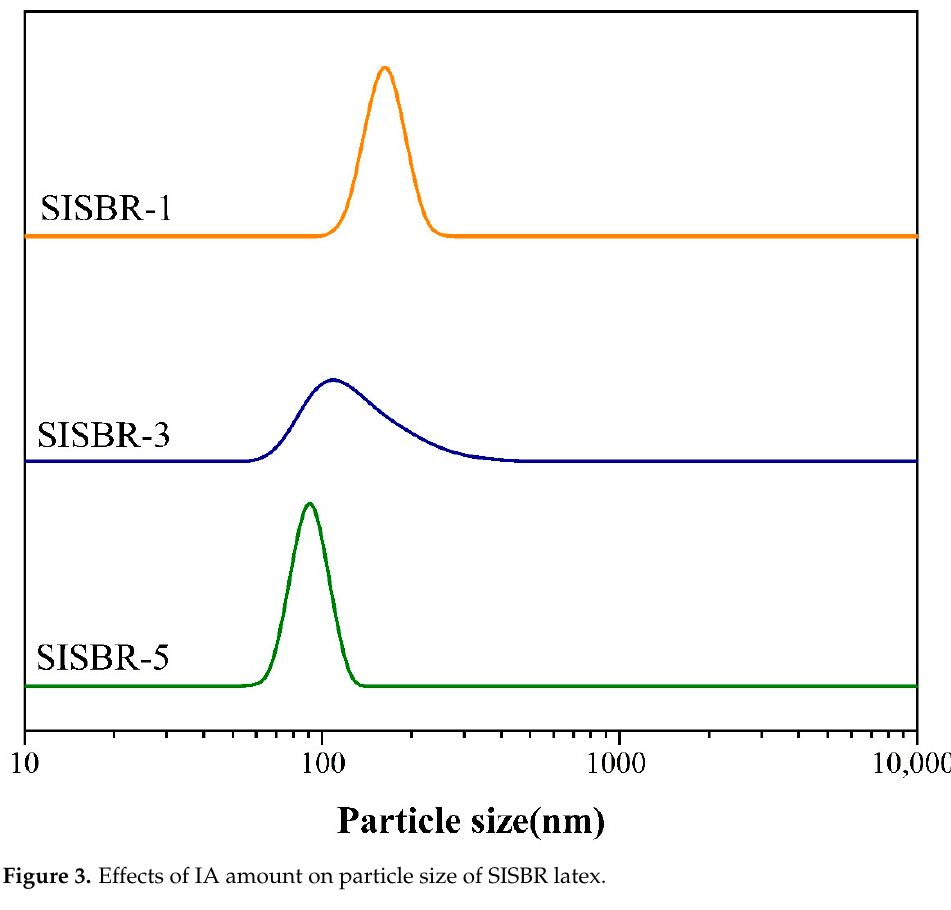
Figure 3. Effects of IA amount on particle size of SISBR latex.